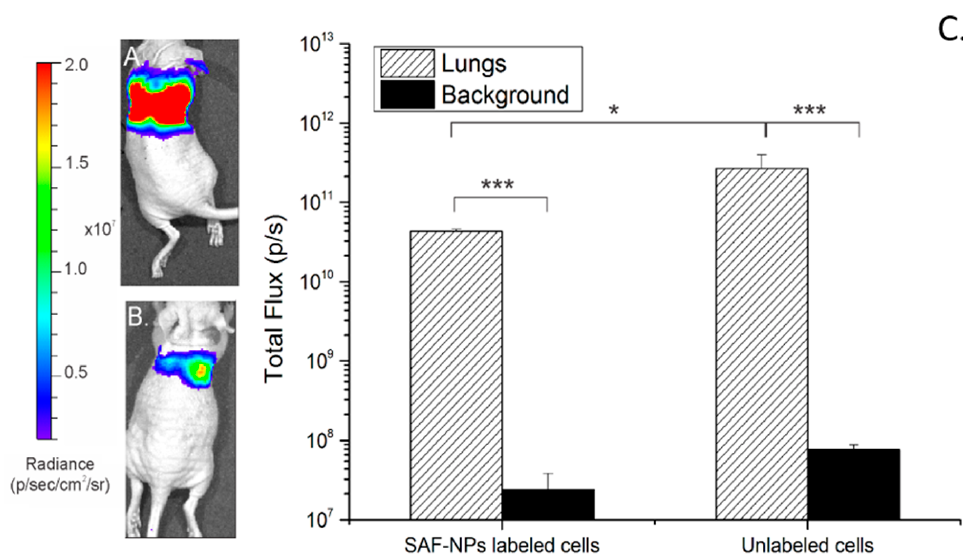
Figure 9. BLI of a mouse after injection of 500,000 unlabeled ( A ) and SAF-NP-labeled SKOV3 cells ( B ). ( C ) A high BLI signal intensity is observed in the lungs of the mouse in both cases, indicating cell accumulation in the lung region. Quantification of the total flux plot on a log scale shows a difference in BLI signal for the mice injected with either 500,000 unlabeled or SAF-NP-labeled SKOV3 cells. * p < 0.05 *** p < 0.001.